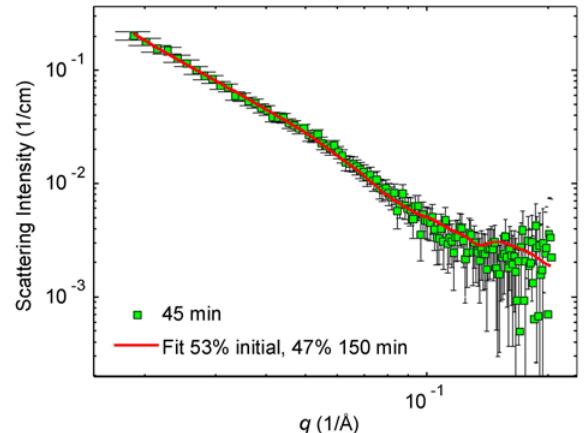
Figure 7. The scattering pattern of the 45 min sample (green squares). The solid red line is the corresponding “bimodal” model fit with the contribution of 53% of initial and 47% initial sample. See text for details.